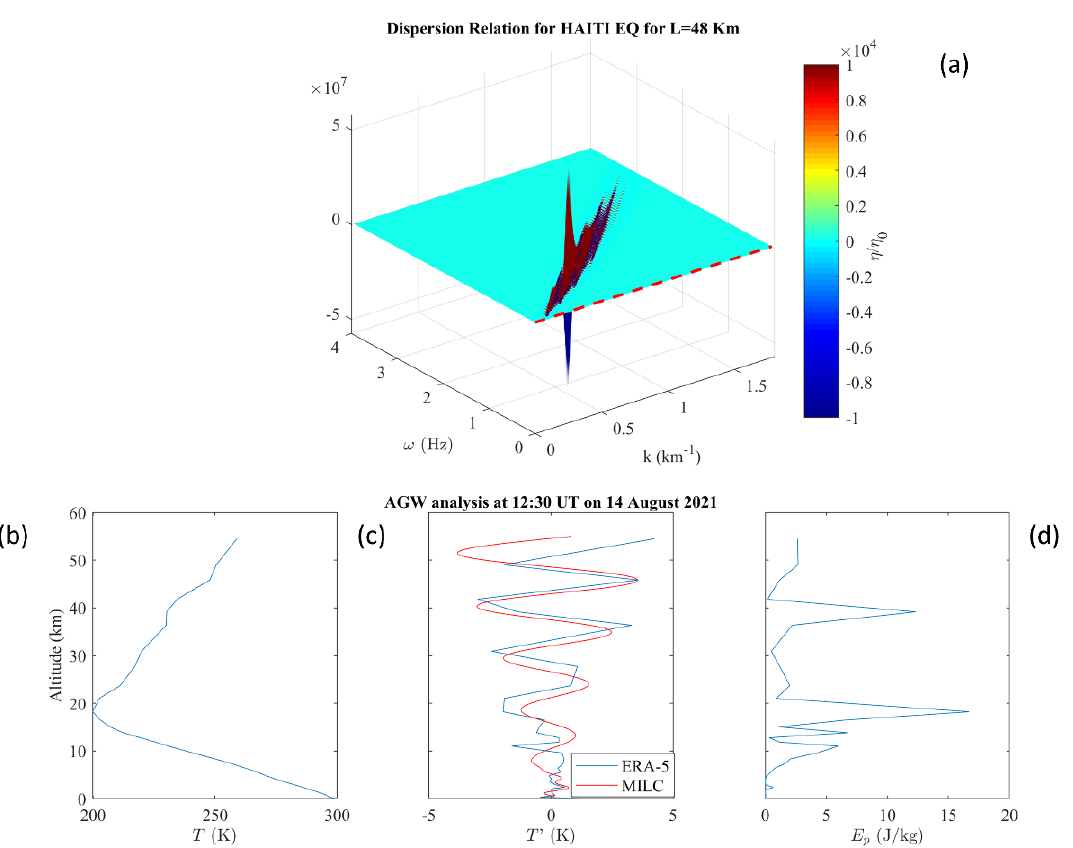
Figure 8. MILC model previsions for the AGW detected on occasion of the Haitian EQ on 14 August 2021. Panel ( a ) shows the dispersion relation of the AGW frequency and wavelength predicted by the MILC model, in which the red dashed line represents the parameter c 0 /2 h. Panel ( b ) shows the atmospheric temperature profile as observed by ERA-5; panel ( c ) shows the atmospheric temperature profile observed (blue line) vs. the predicted (red line); panel ( d ) shows the atmospheric potential energy